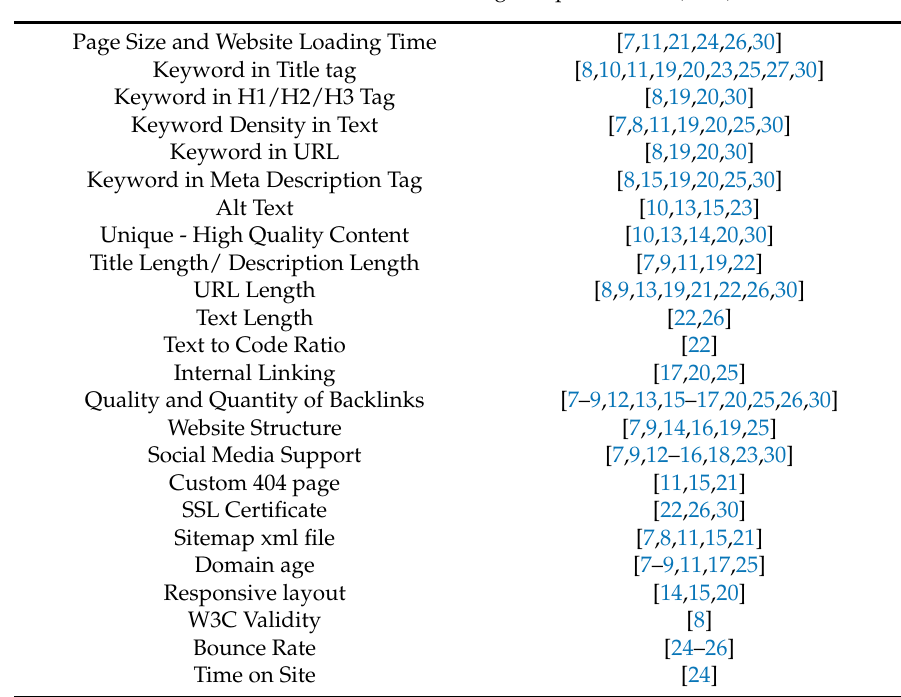
Table 1. Previous research on search engine optimization (SEO)